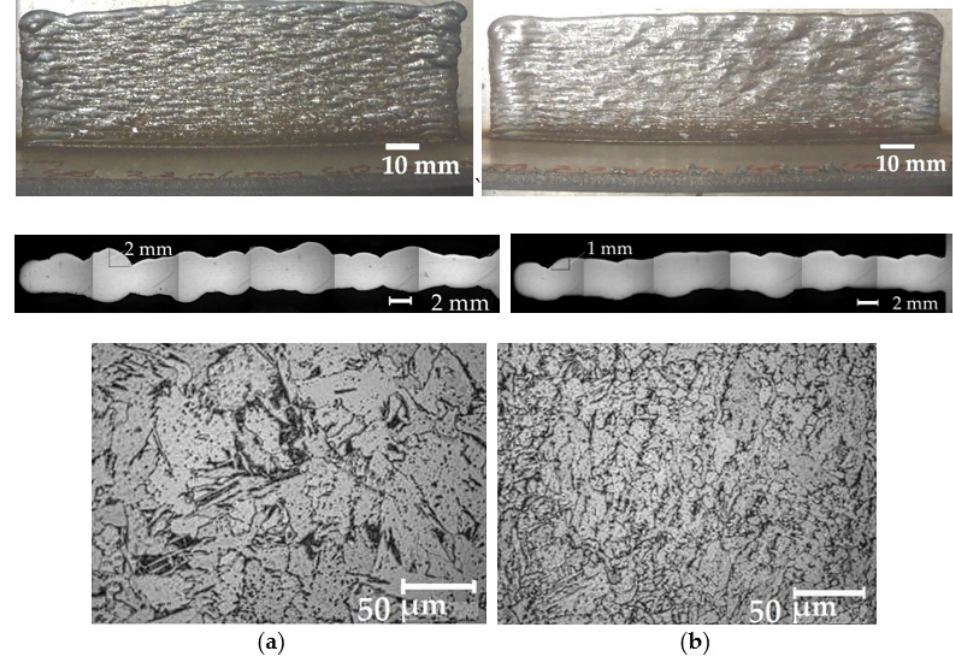
Figure 17. Formation, macrostructure and microstructure of a vertical specimen cross-section with 316L wire of 1 mm: ( a ) uncoated wire, specimen thickness is 4 mm, layer thickness is 2–2.5 mm; ( b ) wire with Ni-LaB 6 composite coating, specimen thickness is 4 mm, layer thickness is 1.5–2 mm.